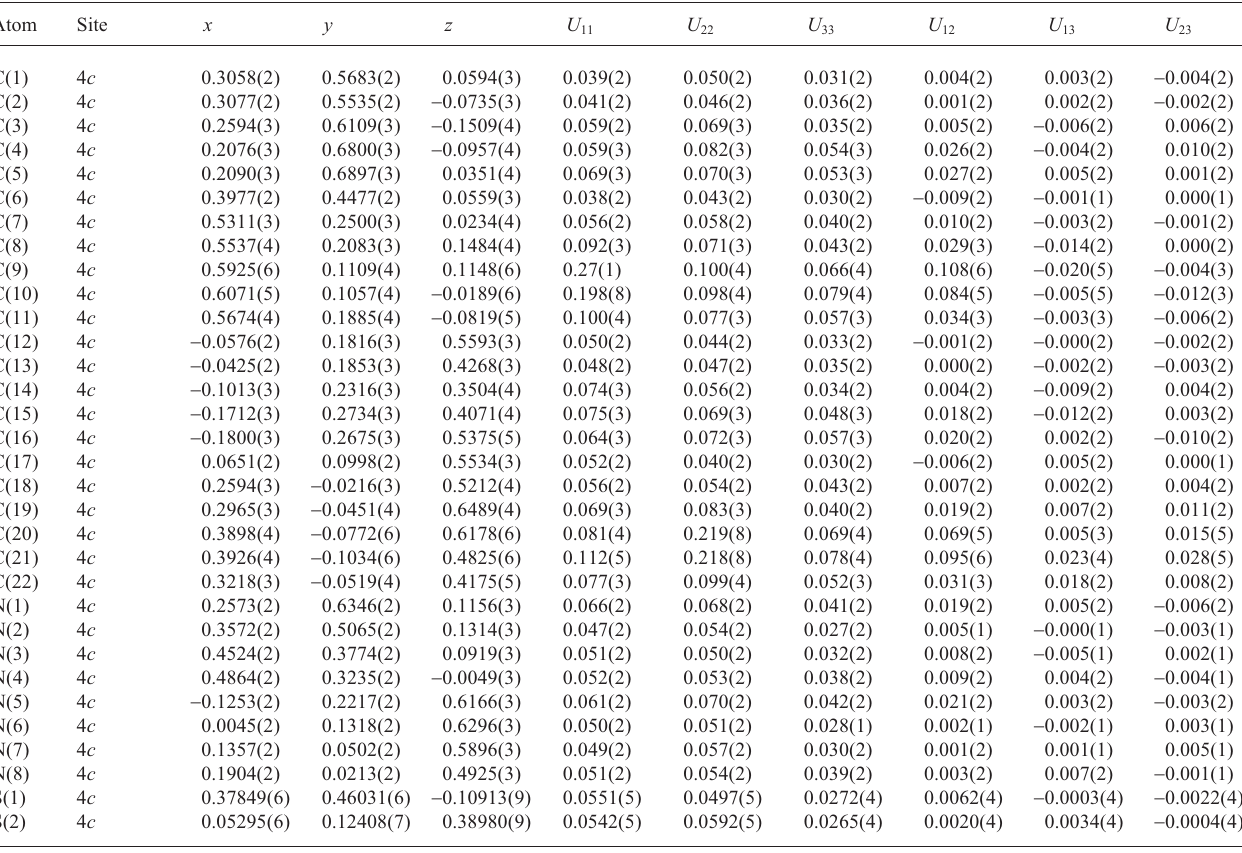
Table 3. Atomic coordinates and displacement parameters (in Å 2 )